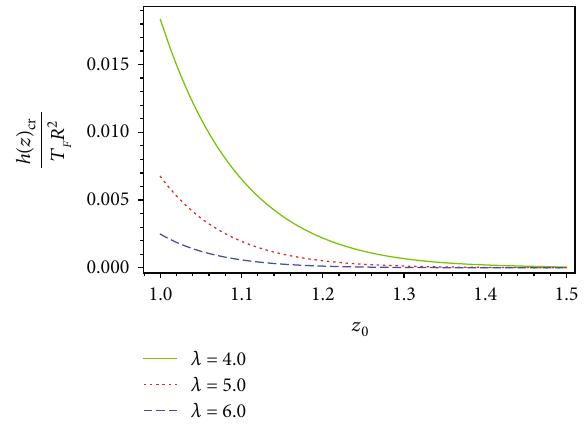
Figure 1: Considering the critical fi eld against probe brane position, at zero temperature and for di ff erent values of scale